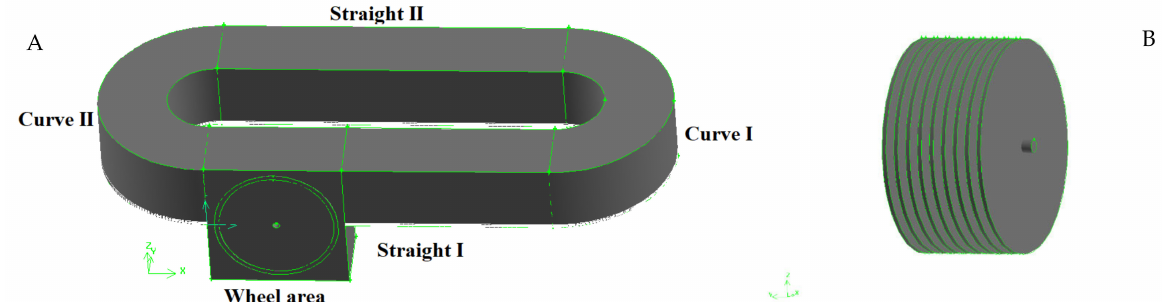
Figure 2. Flume model establishment and partition. ( A ) Overall generalization of the model, ( B ) generalization of the wheel